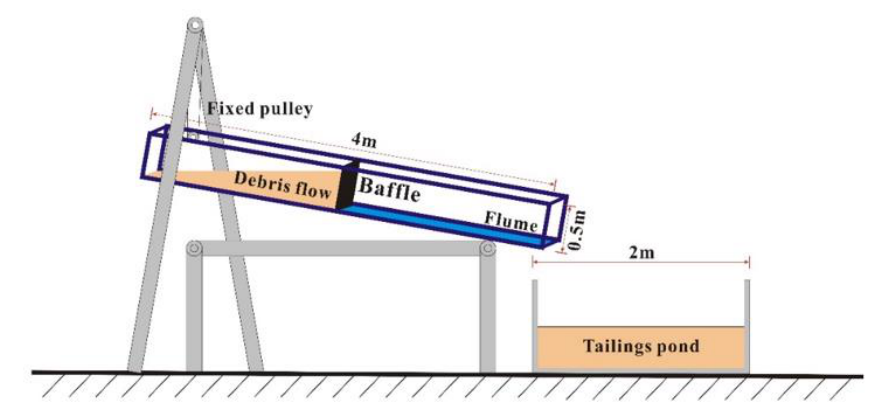
Figure 4. Sketch of the experimental setup.